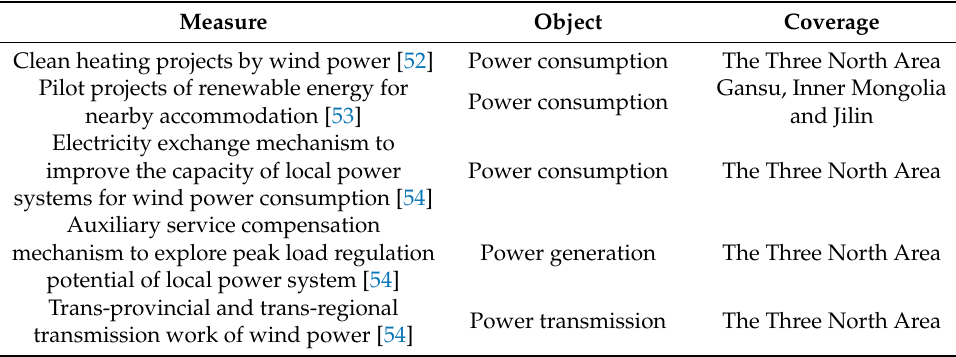
Table 6. Measures for wind curtailment in the Three North Area.